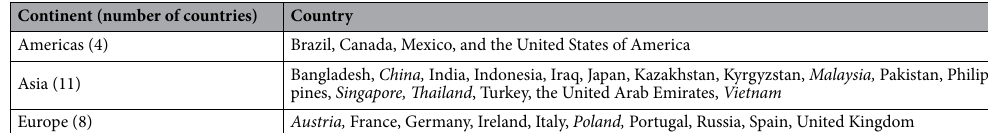
Table 3. Countries selected as eligible for model fitting. The seven countries in Italic were excluded from the model fitting procedure as there were no reported imported cases from these countries after 1 April,